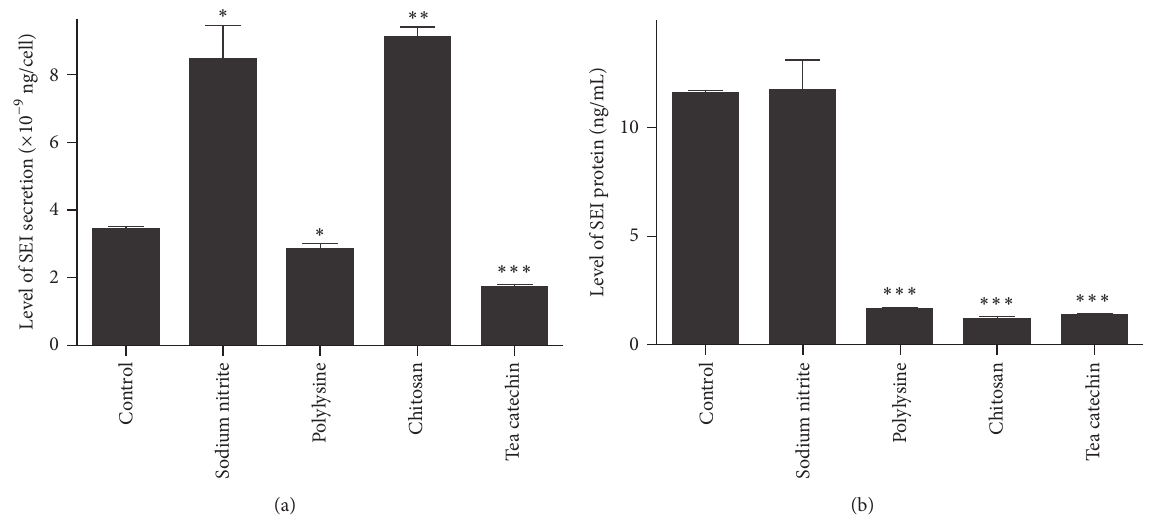
Figure 3: Influence of different food preservatives on extracellular SEI secretion. S. aureus H4 was administrated with sodium nitrite, polylysine, chitosan, or tea catechin, respectively, as described above. At the 24th-hour incubation, the level of SEI in supernatant of S. aureus H4wastestedbydouble-antibodysandwichELISA.(a)ThelevelofSEIproducedbyperbacterium.(b)Theconcentrationoftotalextracellular SEI ( ∗ 𝑝 < 0.05 , ∗∗ 𝑝 < 0.01 , and ∗∗∗ 𝑝 < 0.001